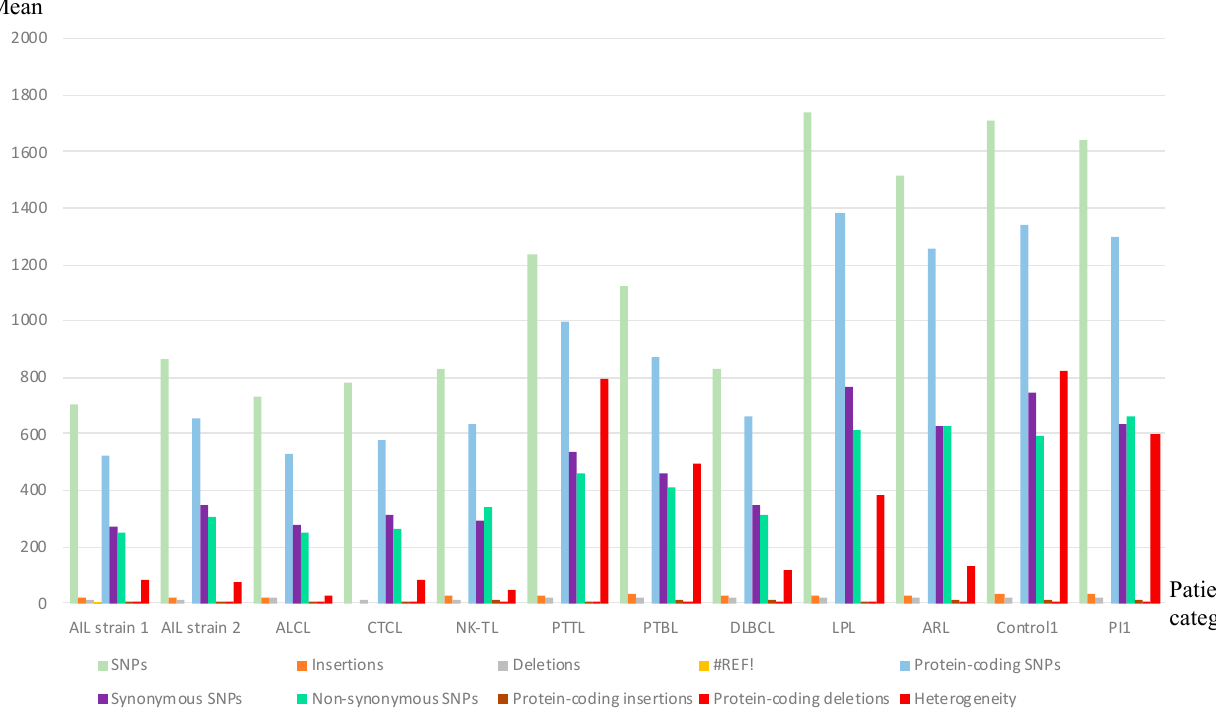
Figure 1. Mean genetic variations and heterogeneity determination for all categories of patients.